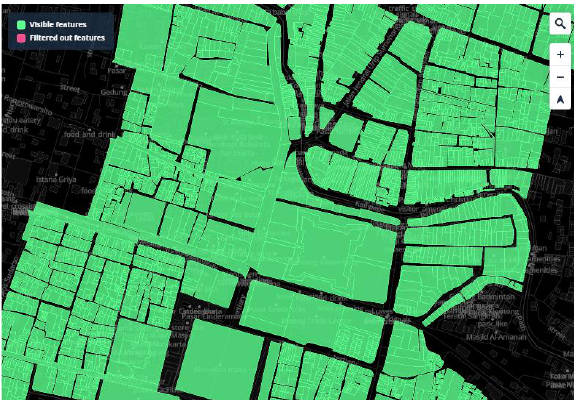
Figure 6. Tiling of parcel data in Mapbox Cloud